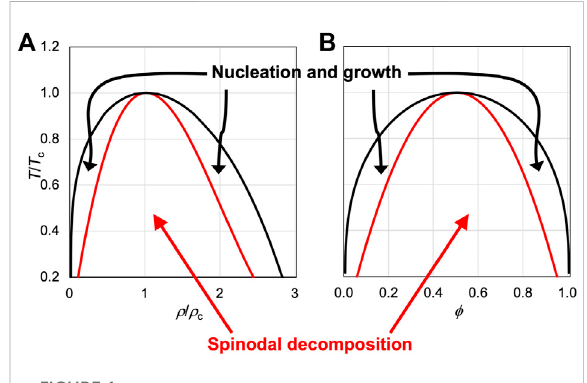
FIGURE 1 Binodals and spinodals of two model systems. (A) Van der Waals fl uid, which satis fi es the following equation of state: ρ c and c denote the critical temperatureandcriticaldensity,and k B istheBoltzmannconstant. (B) Symmetric polymer blend that follows the Flory-Huggins theory for the Helmholtz free energy: